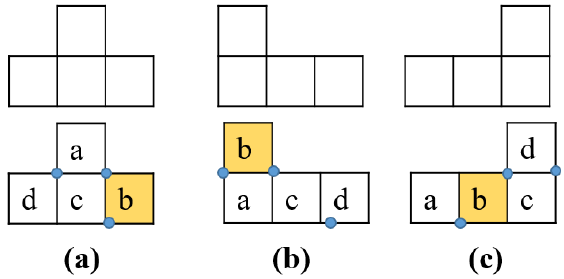
Figure 7. The tiling pattern and corresponding other blocks’ locations considering block b as a reference point for hTetro asymmetric mythologies. ( a ) T shape; ( b ) J shape; ( c ) L